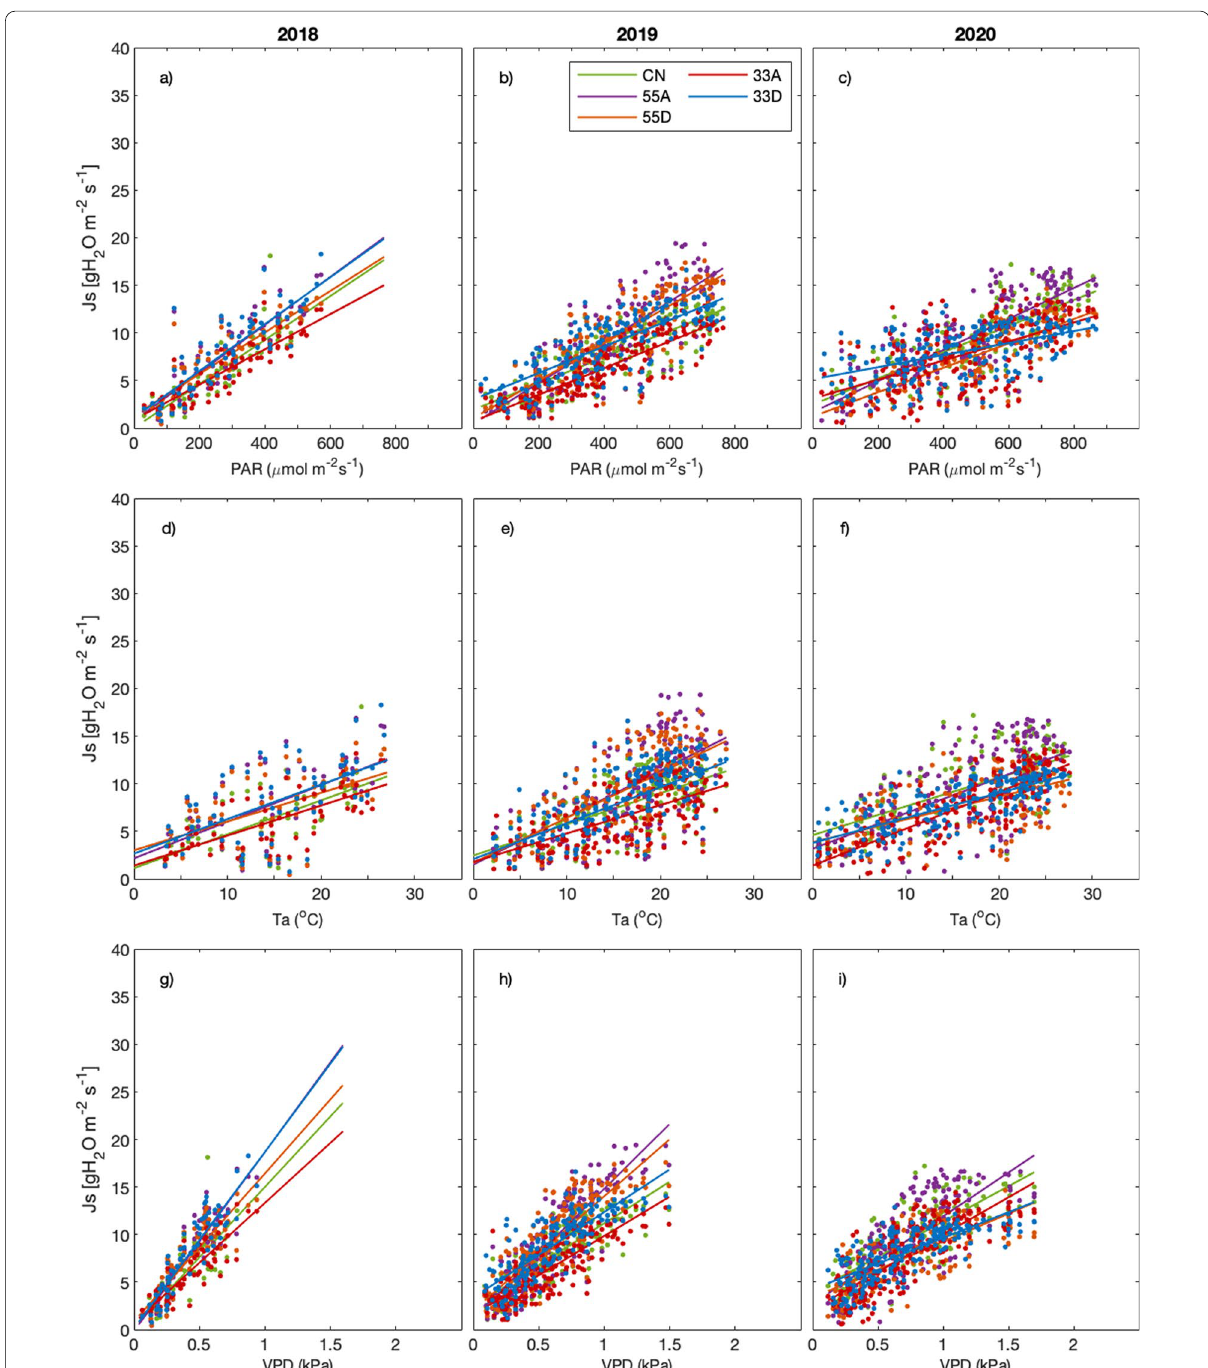
Fig. 6 Scatter plots showing the correlation between daily average sap flux density ( J s ) and photosynthetically active radiation (PAR; a – c ), air temperature (Ta; d – f ) and vapour pressure deficit (VPD; g – i ) for 2018, 2019 and 2020. R 2 values are displayed in Table 2 ( p <